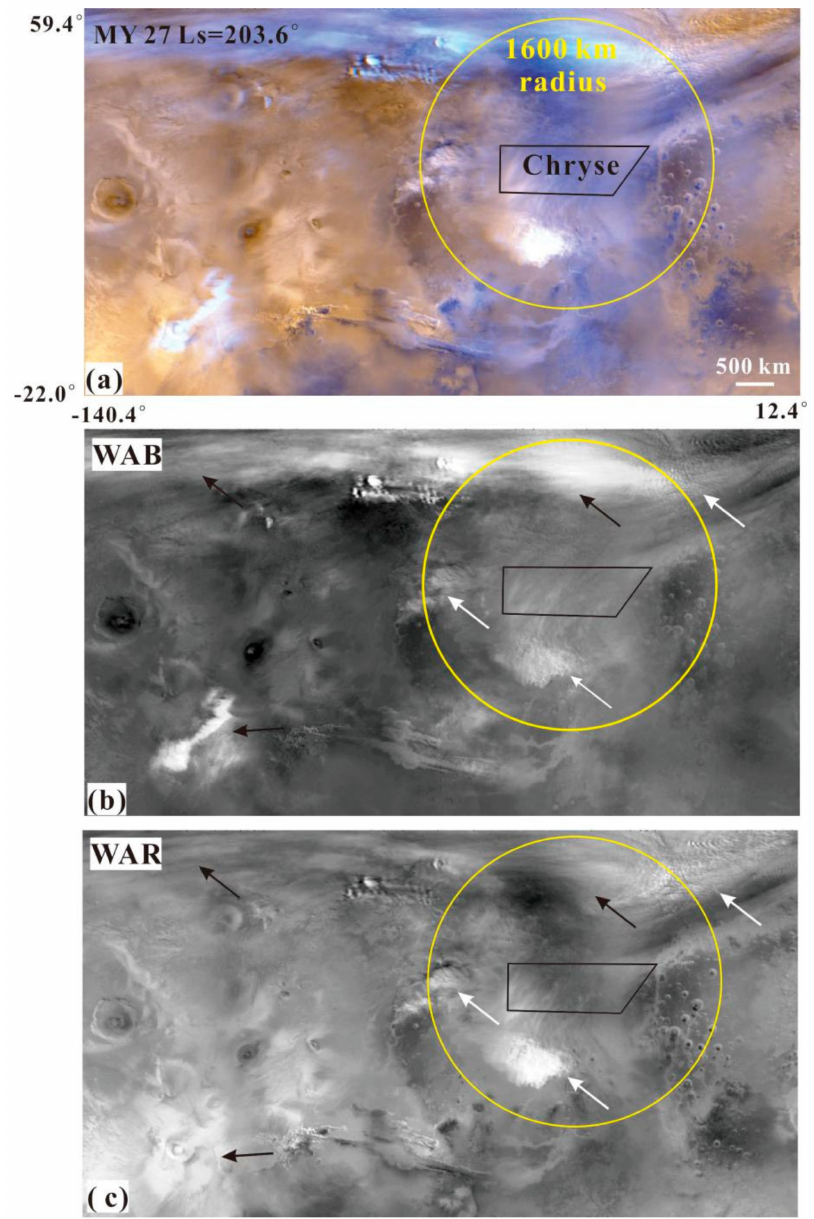
Figure 2. ( a ) Example of a MOC MDGM section (MY 27, Ls = 203.6 ◦ ) in Chryse Planitia. ( b , c ) are the blue and red bands of this image. These two wavelengths can discriminate between clouds (black arrows) and dust storm activity (white arrows). The black polygon and yellow circles are the Chryse landing area and its 1600 km-radius monitoring ring,